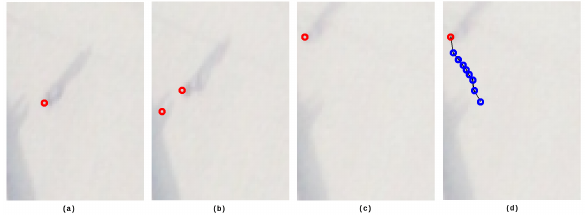
Figure 3: Tracking process of one person. (a) A sub-region from Stadium 1 test image, (b) A sub-region from Stadium 6 test im- age (includes also a false detected person location), (c) A sub- region from Stadium 15 test image, (d) Detected motion path of the person.